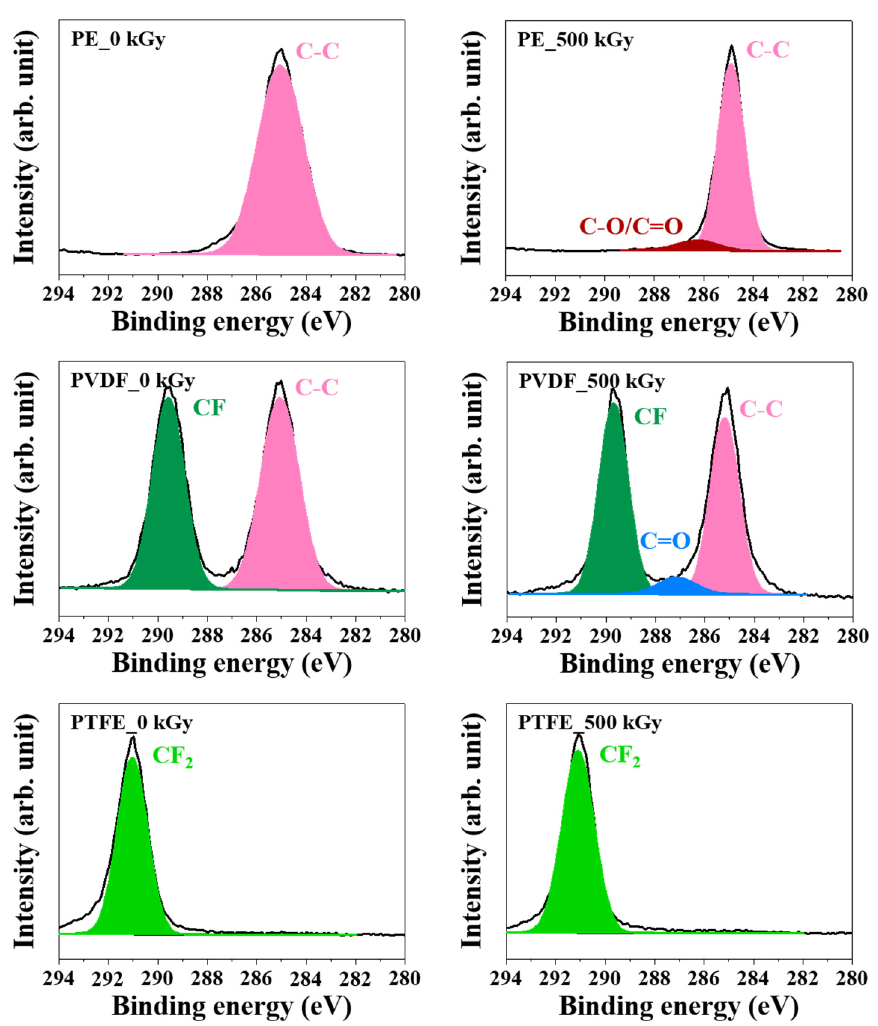
Figure 3. The deconvoluted XPS C1s narrow spectra of PE, PVDF, and PTFE, before and after gamma-ray irradiation.